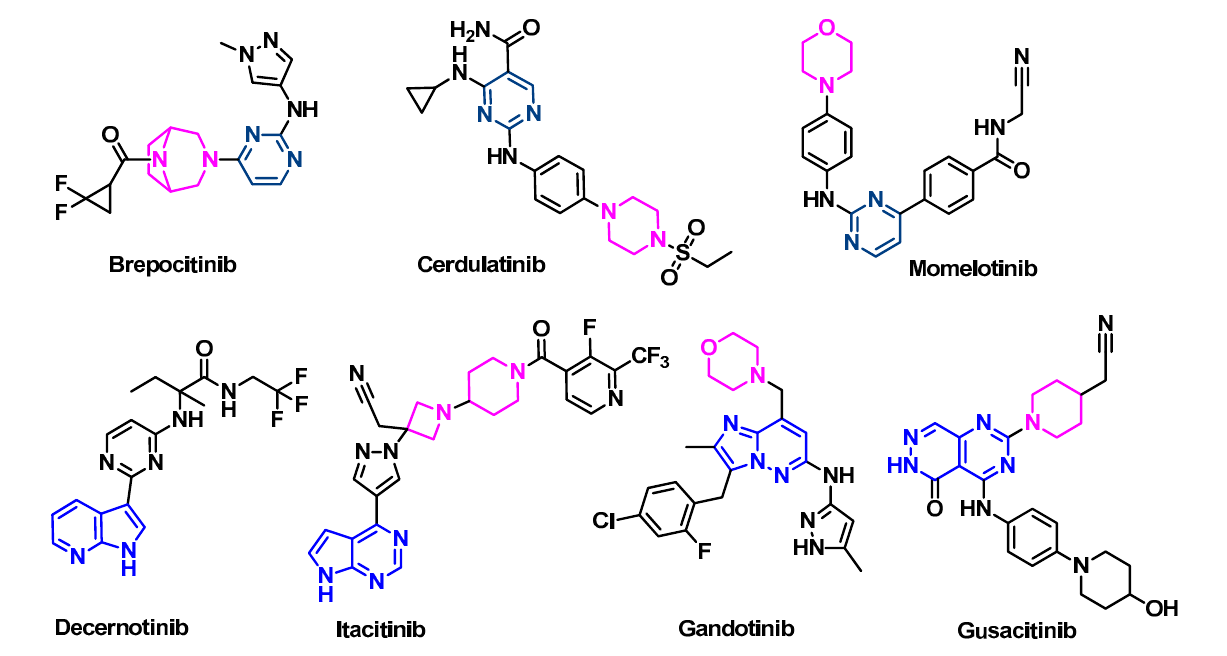
Figure 68. JAK inhibitors under